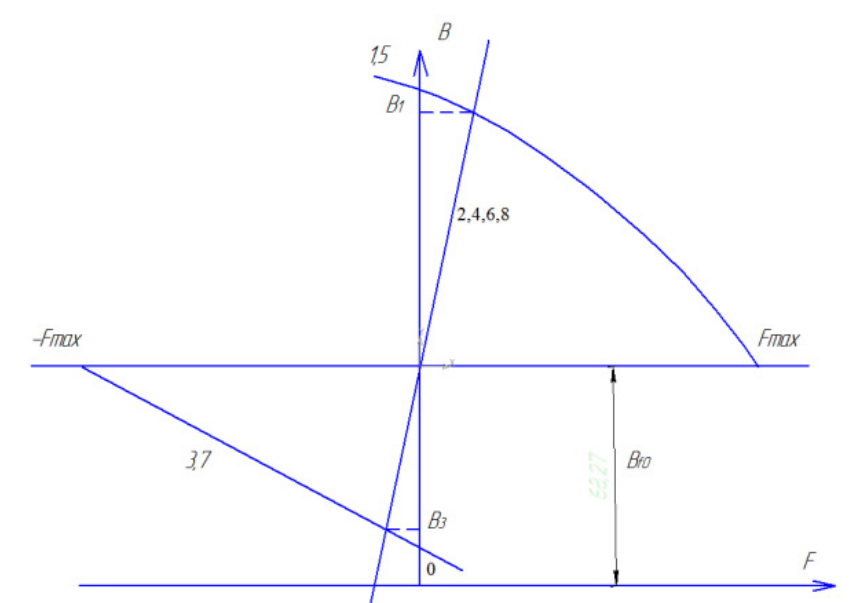
Figure 1. Graphic-analytical calculation of the field.